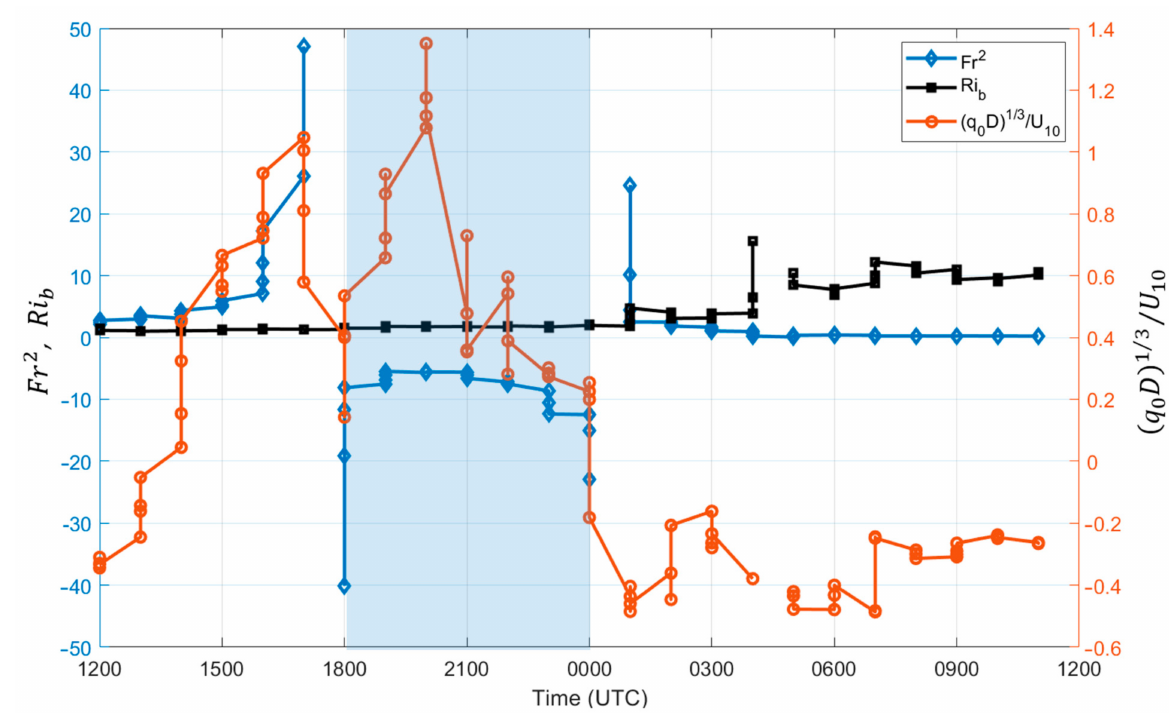
Figure 13. WRF Fr 2 , Ri b , and ( q 0 D ) 1/3 / U 10 , 17 April 2018. The blue box indicates the time-period when LRS are present.